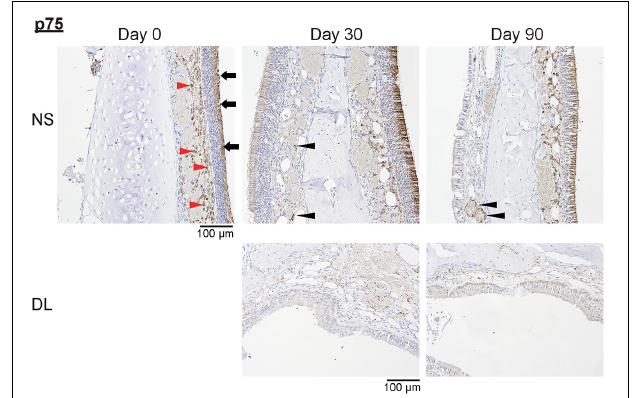
FIGURE 4 | Representative images of sections of the nasal mucosa stained with antibodies against p75 (magnification, 200 × ). NS, nasal septum; DL, dorsolateral area. P75 + olfactory ensheathing cells (red arrowheads) and p75 + uppermost superficial layer cells (black arrowheads) in the nasal mucosa were identified by immunohistochemical staining (brown).